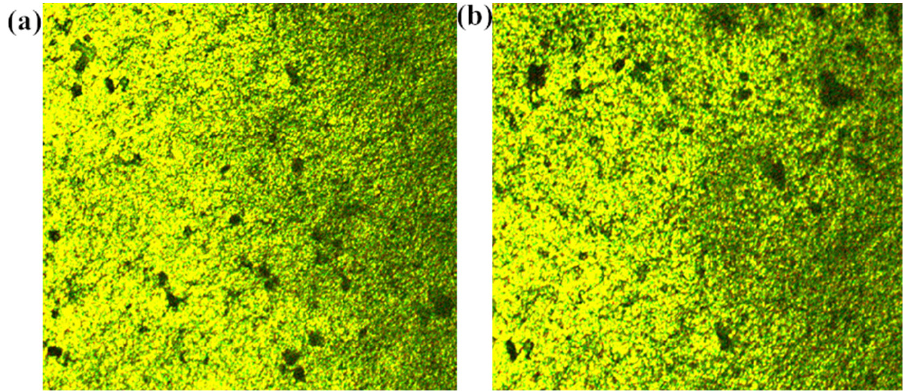
Figure 6. Morphology based on polarizing microscopy (*200): ( a ) CS/PVA/MMT@Pd (no reaction), ( b ) CS/PVA/MMT @Pd (after one reaction).